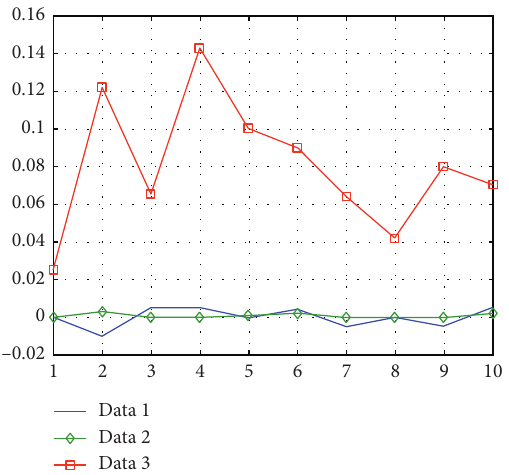
Figure 6: Distribution of median, mean value, and standard deviation ( X : distance (m)).